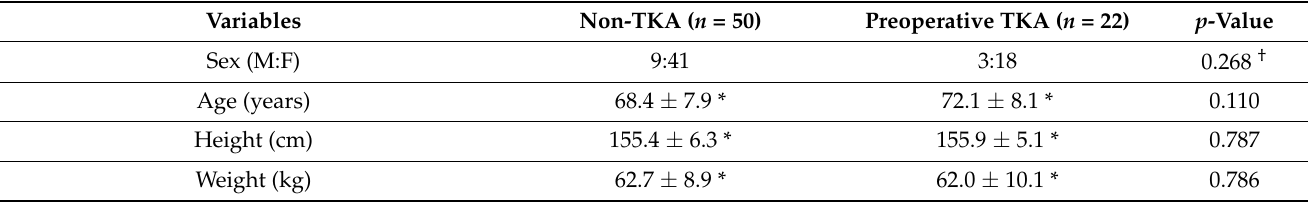
Table 1. Demographic and operative data for spinal fusion only and preoperative TKA with spinal fusion groups. Variables Non-TKA ( n =